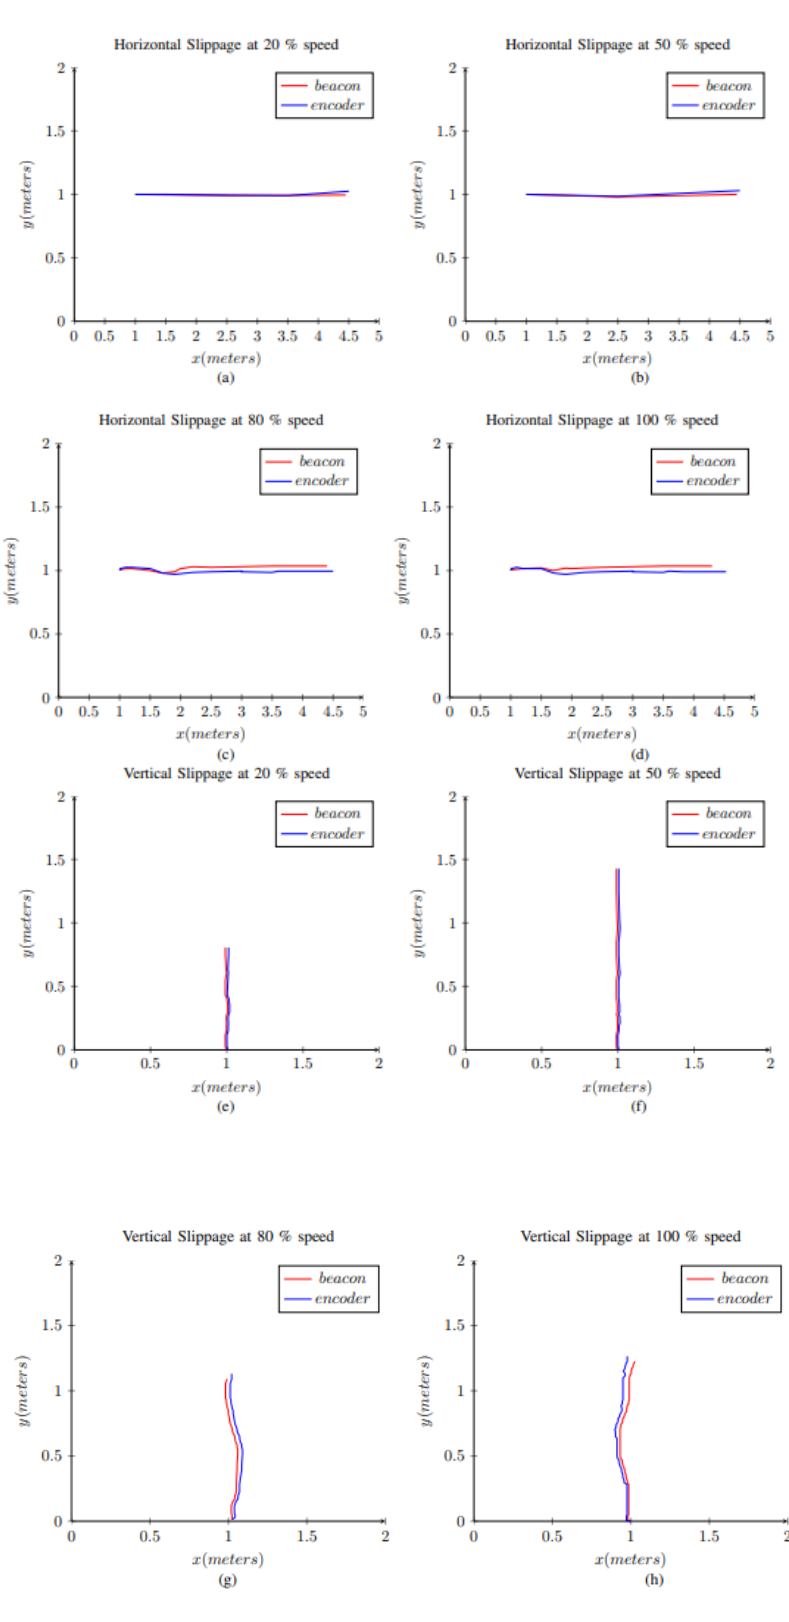
Figure 8. Slippage test results for both horizontal and vertical motion with the motor speed of 20% ( a , e ), 50% ( b , f ), 80% ( c , g ), and 100% ( d , h